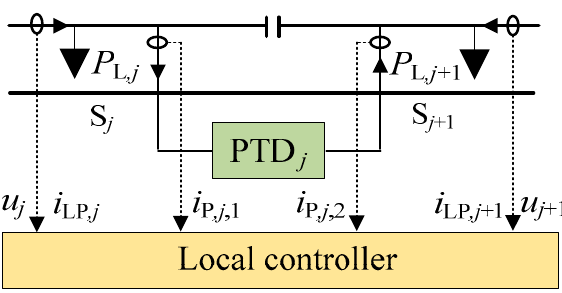
Figure 16. The data information needed to be detected in decentralized control of the PTD.